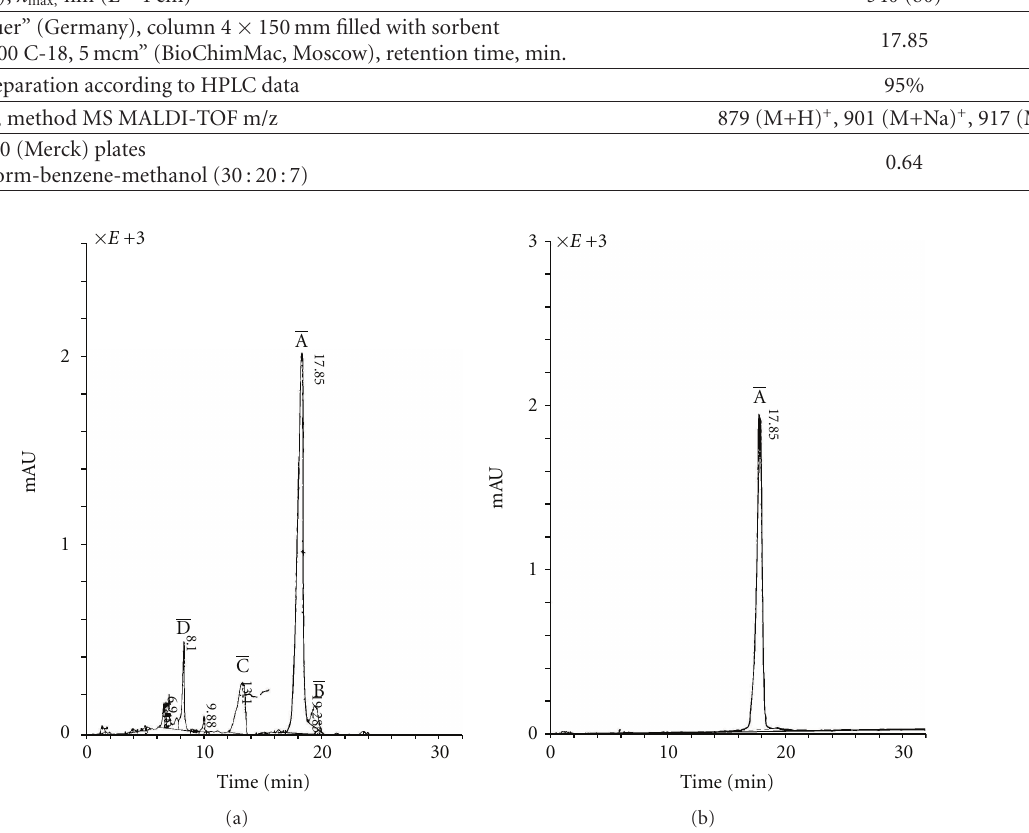
Figure 2: (a) HPLC of antibiotic compound no. 70 . HPLC analysis was conducted on liquid chromatographer “Knauer” (Germany) with automated data processing system and spectrophotometric detector K = 2501. The chromatographic conditions used were as follows: flow rate, 1mL/min; detection at wave length 260 and 300 nm; room temperature; loop, 20 μ L. Preparative isolation of components of the antibiotic compound A-70 was carried out through elution with a mixture of acetonitrile and water; the content of acetonitrile was gradually increased from 10 to 60%. The main component of the compound is the component with a retention time of 17.85 min. This component constitutes 72–74% of the compound, and was labeled as the component 70-A. Figure 2(a) shows the chromatogram of separation of the antibiotic compound no. 70. The component 70-B (retention time = 19.41 min) constitutes approximately 4% of total components. The components C and D are minor and together add up to less than 1%. The conditions for preparative isolation of individual components on chromatographer “Knauer” (Germany) were developed. The salt-free system acetonitrile-water in gradient elution mode from 10 to 60% of acetonitrile with detection at 300 nm met these optimal conditions. (b) HPLC of the extracted and purified main component 70-A. Conditions of HPLC analysis on liquid chromatographer “Knauer” (Germany) were developed for a more precise separation of the antibiotic compound no. 70 and determination of its components’ ratio. By HPLC method, the chromatographically pure sample of the main component 70-A was isolated as shown in Figure